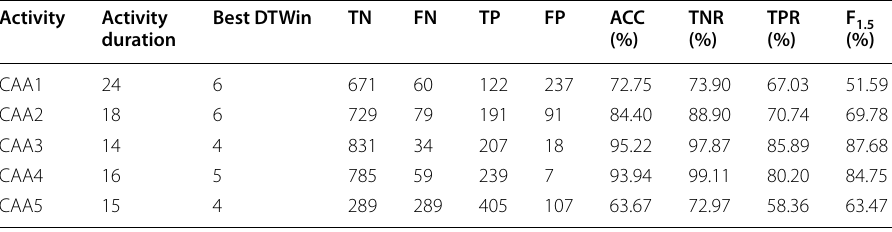
Number of learners (n